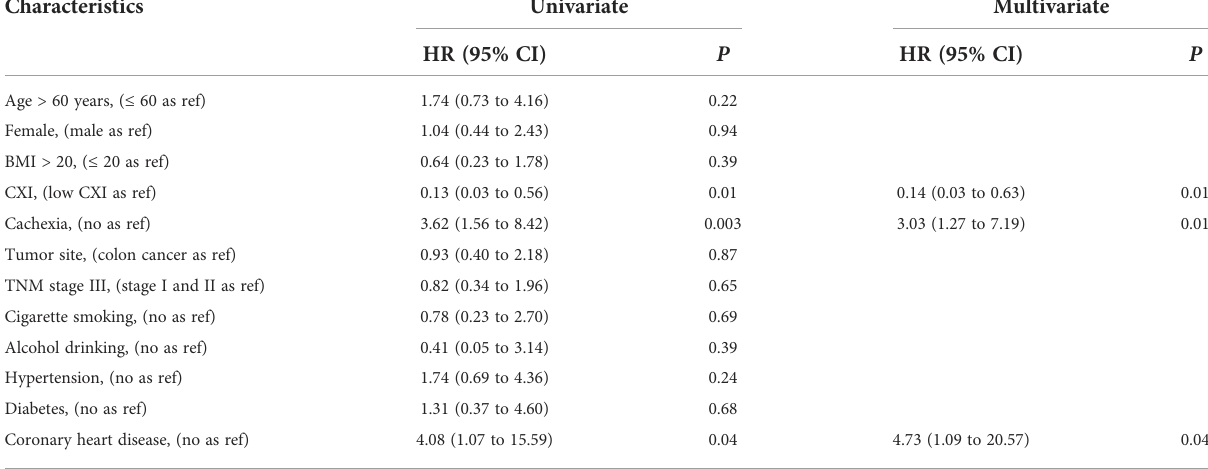
TABLE 2 Univariate and multivariate analysis of major